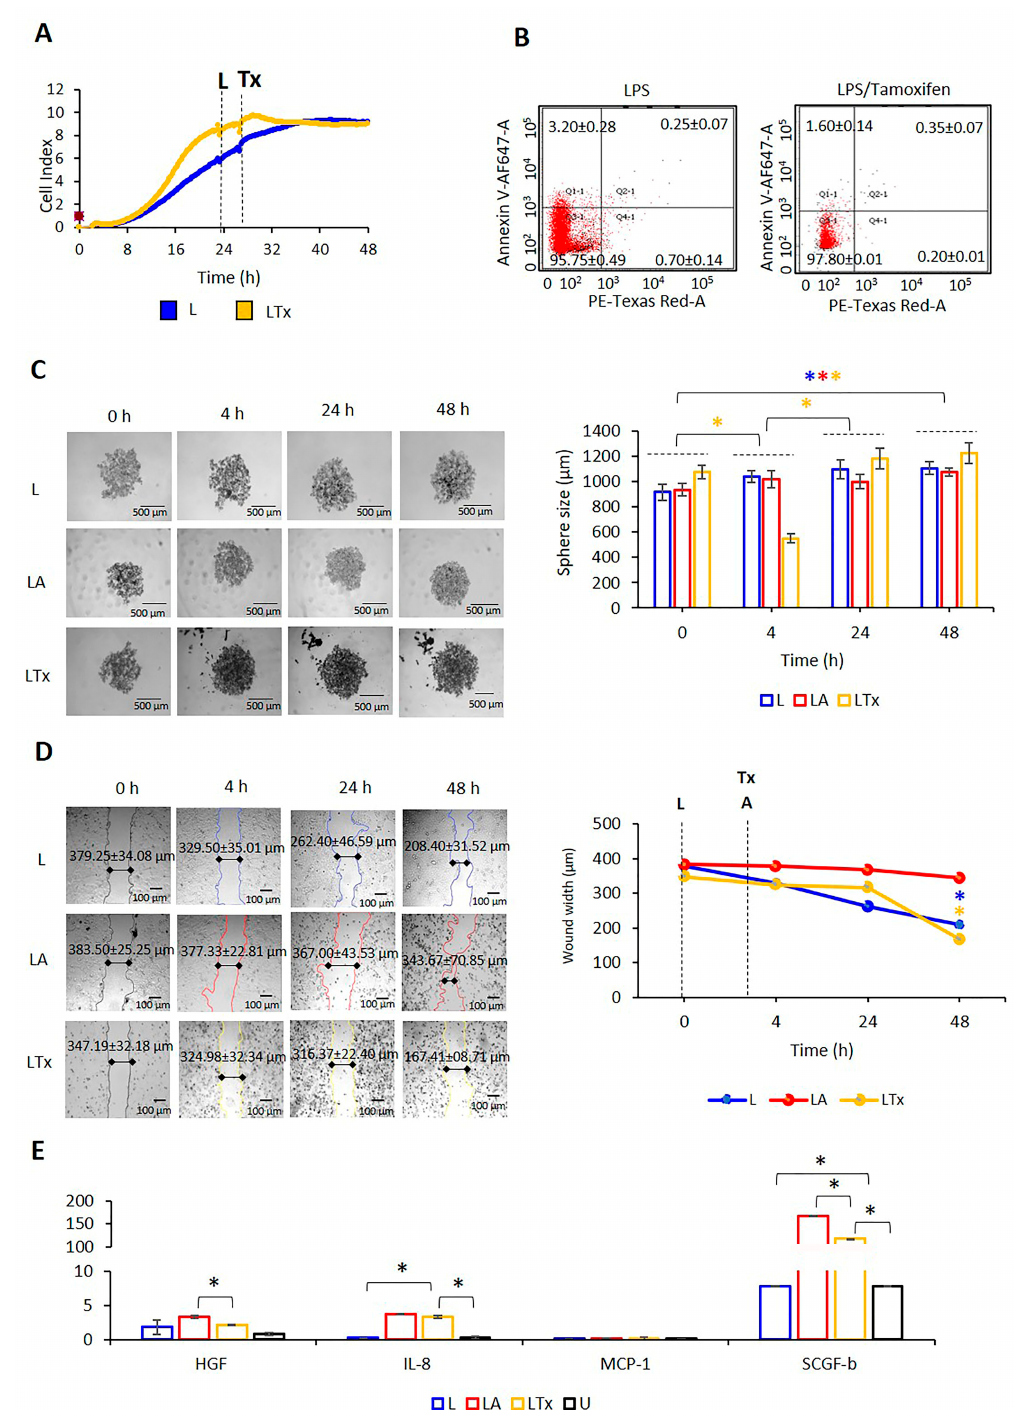
Figure 8. Tx-mediated ER- α suppression affects cell proliferation, sphere formation, and wound healing in LPS/ATP-treated MCF7 cells. ( A ) The effect of L-Tx on proliferation kinetics; ( B ) apoptosis; ( C ) the sphere formation; ( D ) the in vitro closure of the wound healing area; ( E ) HGF, IL-8, MCP-1, and SCGF-b secretion. Data represent three technical repeats for ( A , B , E ) and five technical repeats for ( C , D ). The p -value was calculated using the one-way ANOVA model with Tukey’s post hoc tests for ( A – C ) and independent-samples Kruskal-Wallis test for ( E ). * p < 0.05 (blue: LPS-only-treated cells, red: LPS/ATP-treated cells, yellow: LPS/Tx-treated cells). L: LPS, LA: LPS/ATP, LTx: LPS/tamoxifen, U: untreated.